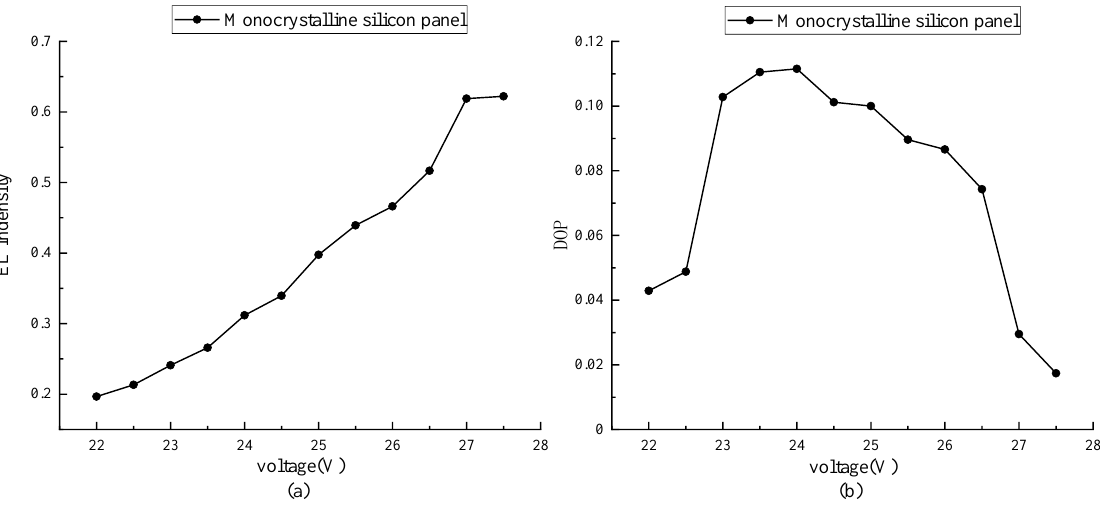
Figure 14. Images DOP of monocrystalline silicon photovoltaic panel with bias voltages.